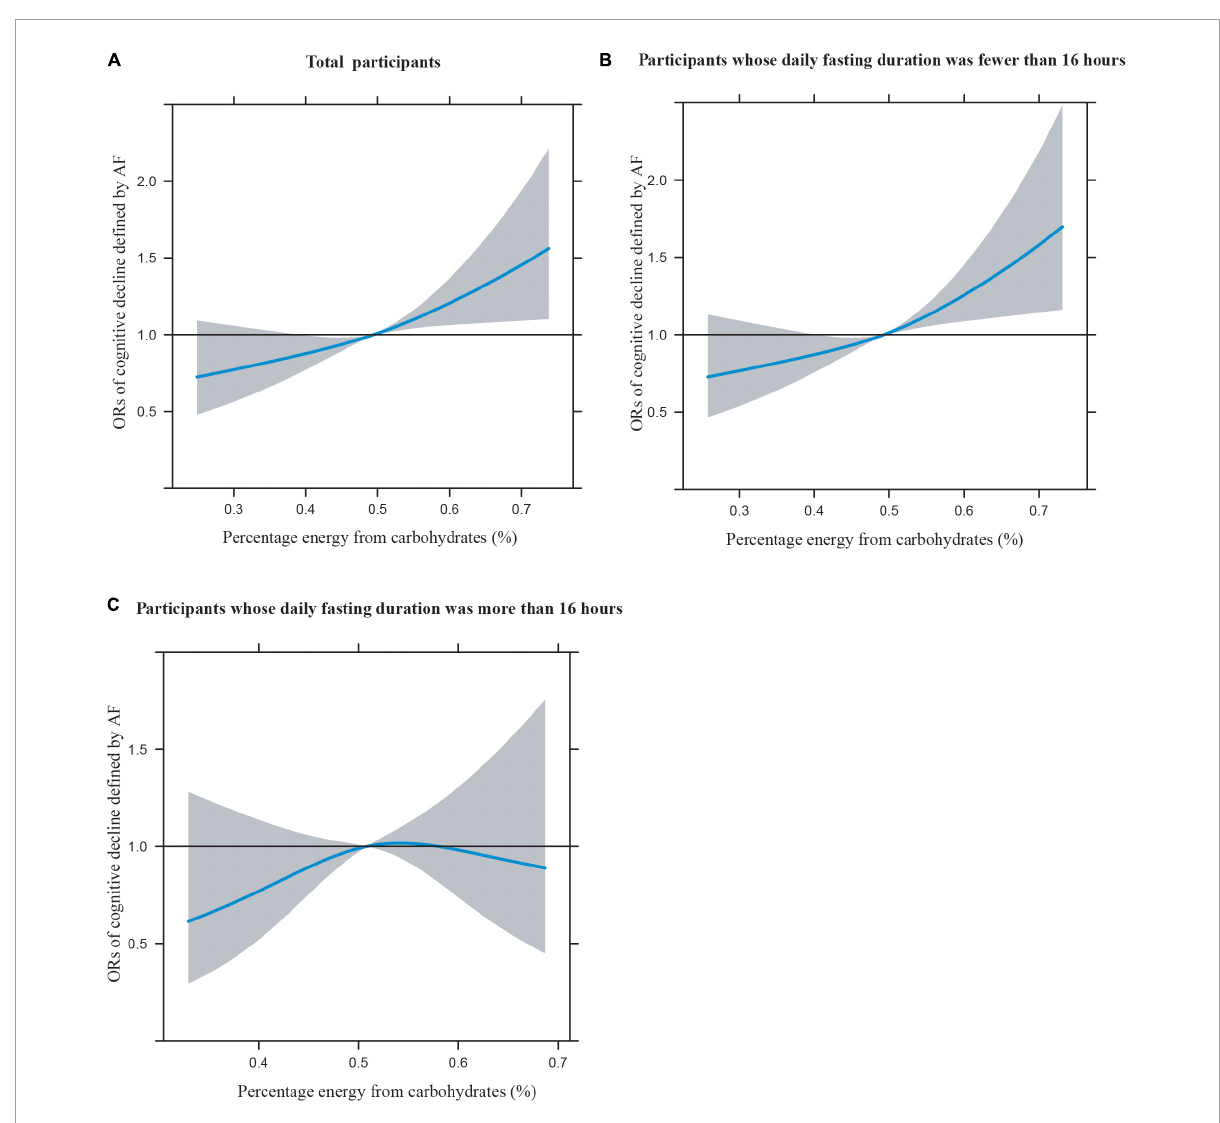
FIGURE4 Restricted cubic splines between percentage energy from carbohydrates (%) and poor cognitive performance of